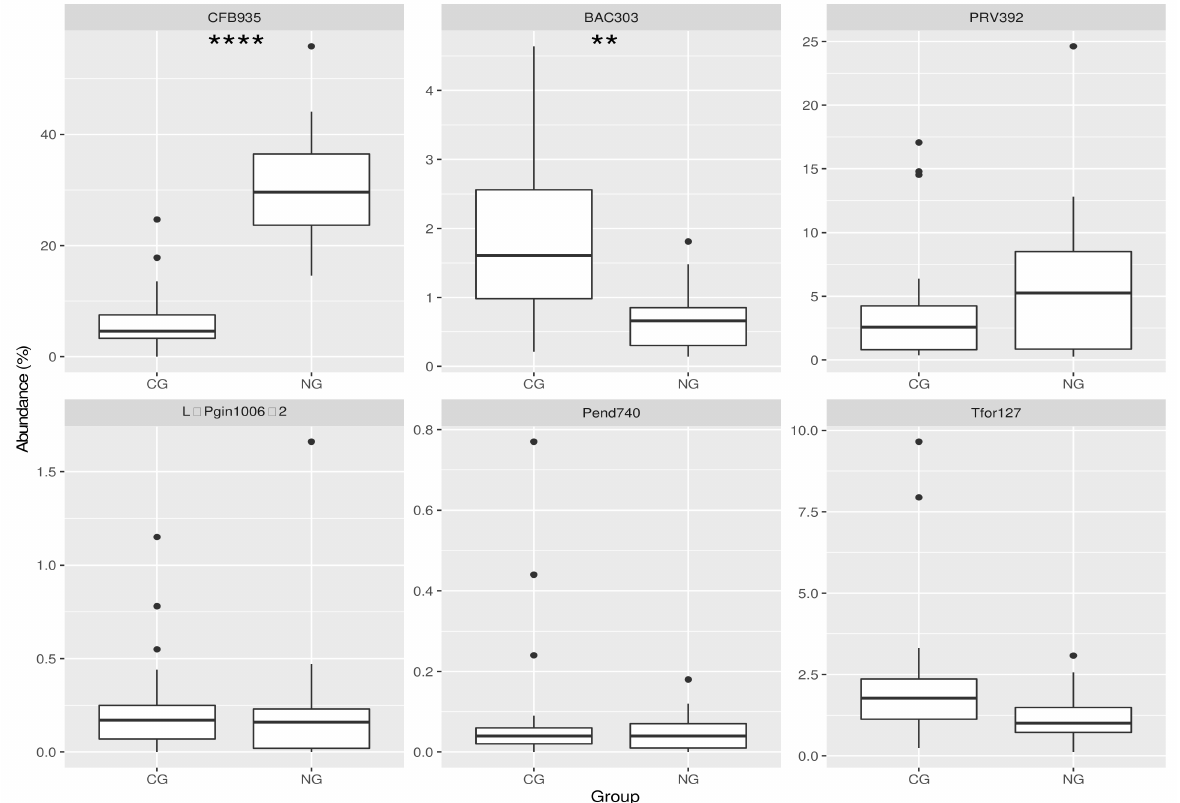
Figure 1. Box plots showing the abundance of six taxa in relation to the total amount of bacteria in samples from patients with chronic (n = 21) or necrotizing gingivitis (n = 21). Data are shown for the phylum Bacteroidetes , the families Bacteroidaceae and Prevotellaceae , the genus Prevotella and the species P. gingivalis , P. endodontalis und T. forsythia . Note that y-axis scales are different for each taxon. 16S rRNA probes used to detect the different taxa are described in Supplementary Table S1. p -values were calculated with the Bonferroni-corrected Mann–Whitney test; p < 0.0001 (****), p < 0.01 (**). CG, chronic gingivitis; NG, necrotizing gingivitis. CFB935; BAC303; PRV392; L–P GIN 1006–2; Pend740; Tfor127 are probes with different targets (see Table